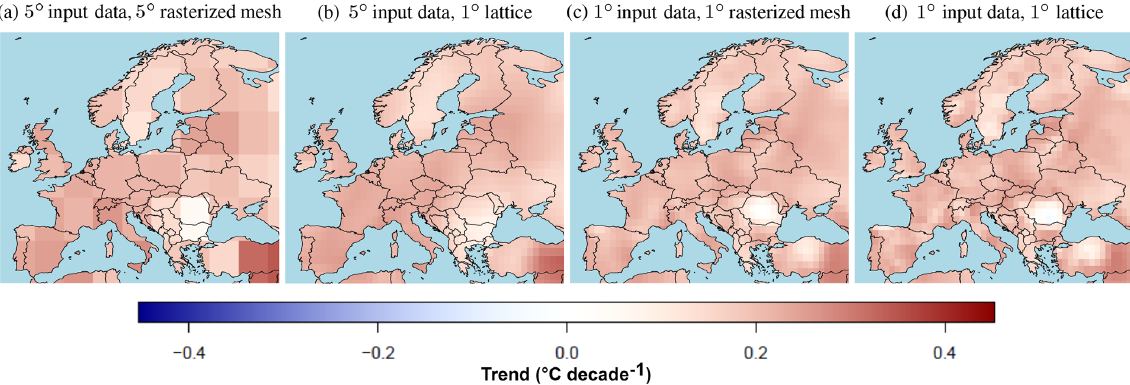
Figure 4. Posterior mean estimates of trends ( ◦ Cdecade − 1 ) in the summer season for 1950–2014 for 5 and 1 ◦ input data grids resolutions. (a, c) Results on the respective rasterized meshes. (b, d) Results projected onto a common 1 ◦ lattice.